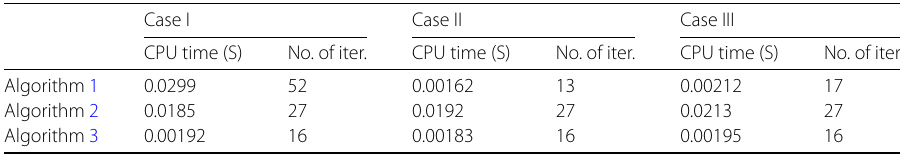
Table 1 Computational results for Example